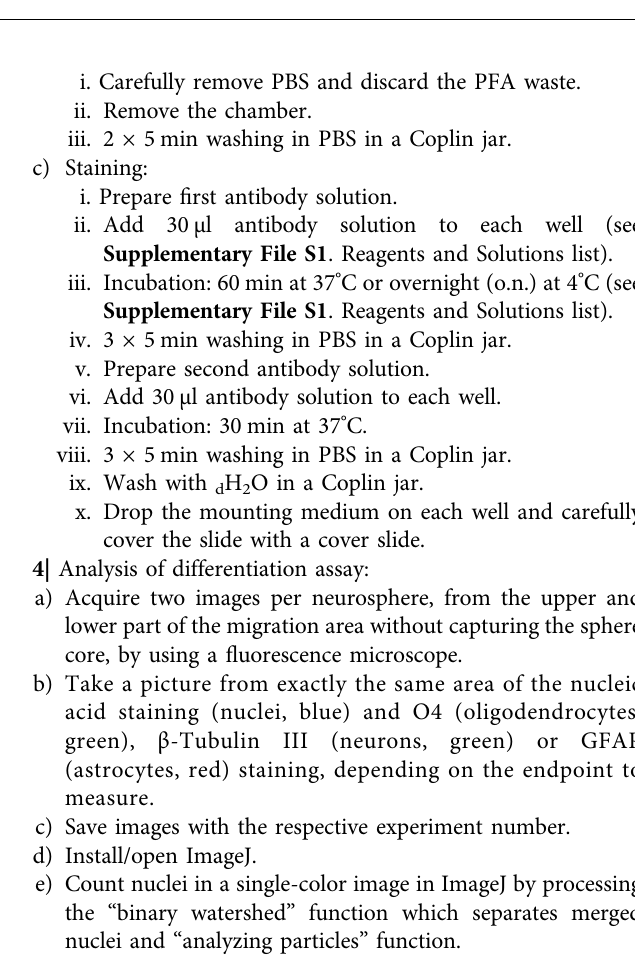
Frontiers in Toxicology |